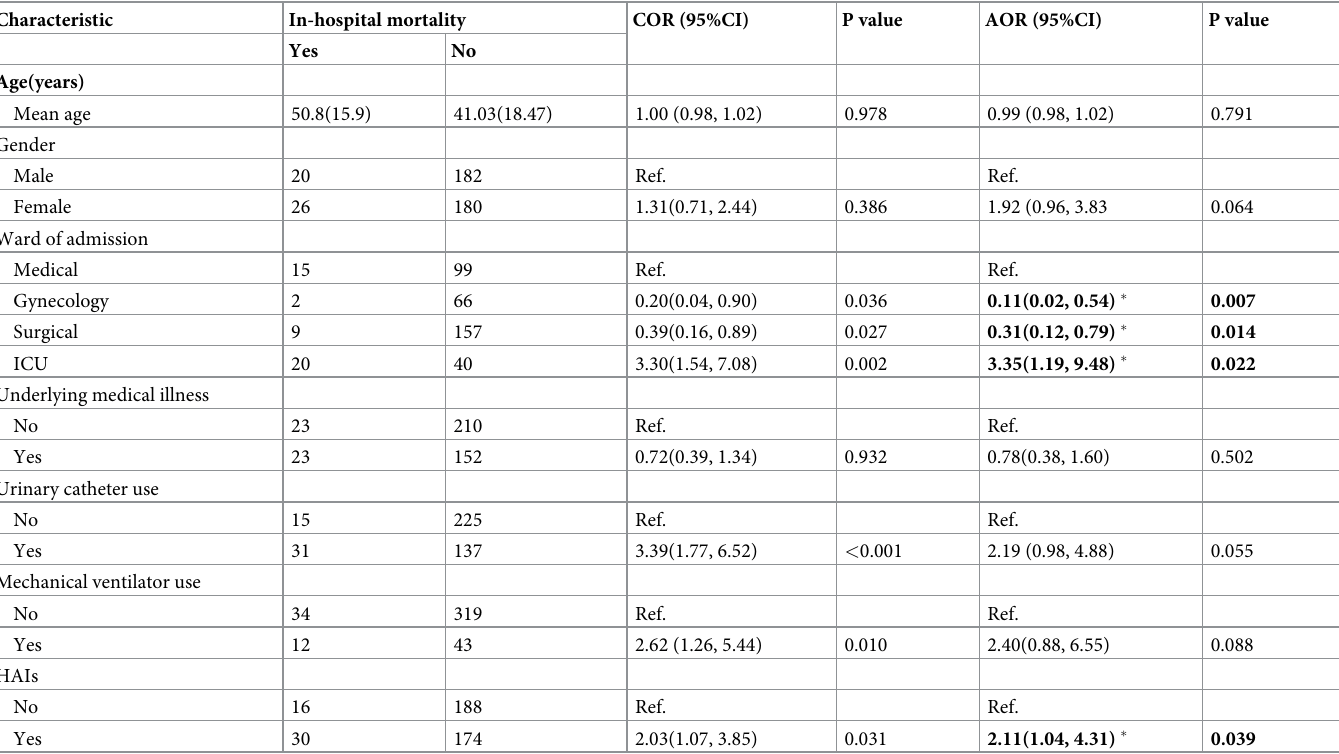
Table 4. Univariable and multivariable logistic regression analysis of predictors of in-hospital mortality at ACSH, Northern Ethiopia, 2019.